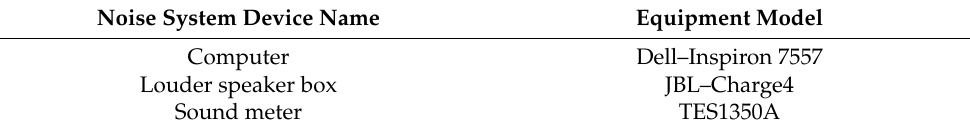
Table 1. Noise test equipment.